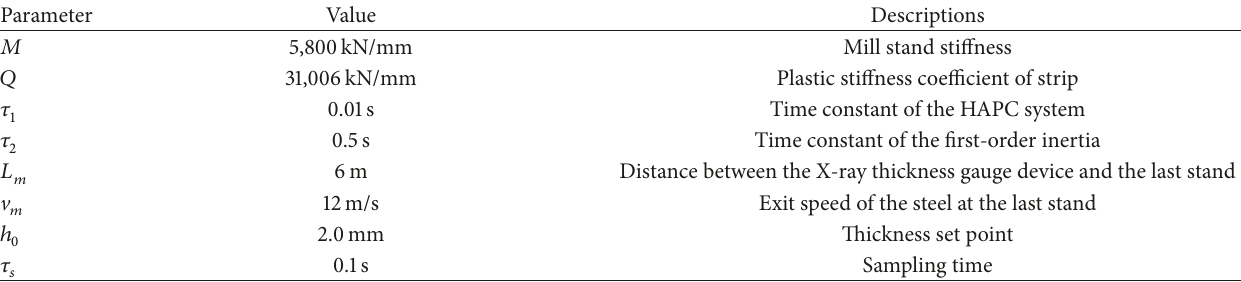
Table 1: Parameters of the monitoring AGC system.